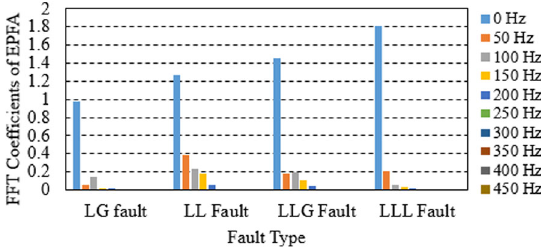
Fig. 7 FFT spectra of EPFA variation with fault conditions of FR = 0 Ω , FIA = 45° in WSCC-9bus